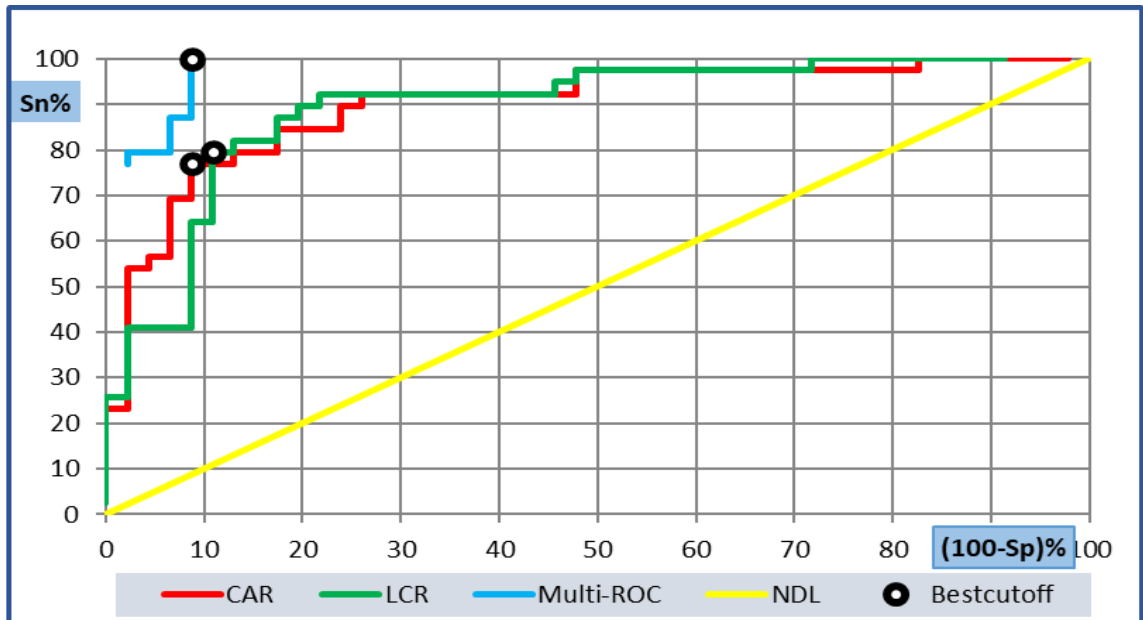
Figure 1. Diagnostic performance of CRP/alb (AUC:0.878; 95%CI: 0.805-0.952); L/CRP (AUC: 0.873; 95%CI: 0.798-0.948) and their combination (AUC: 0.922) for discriminating severe COVID-19 patients from those non- severe.